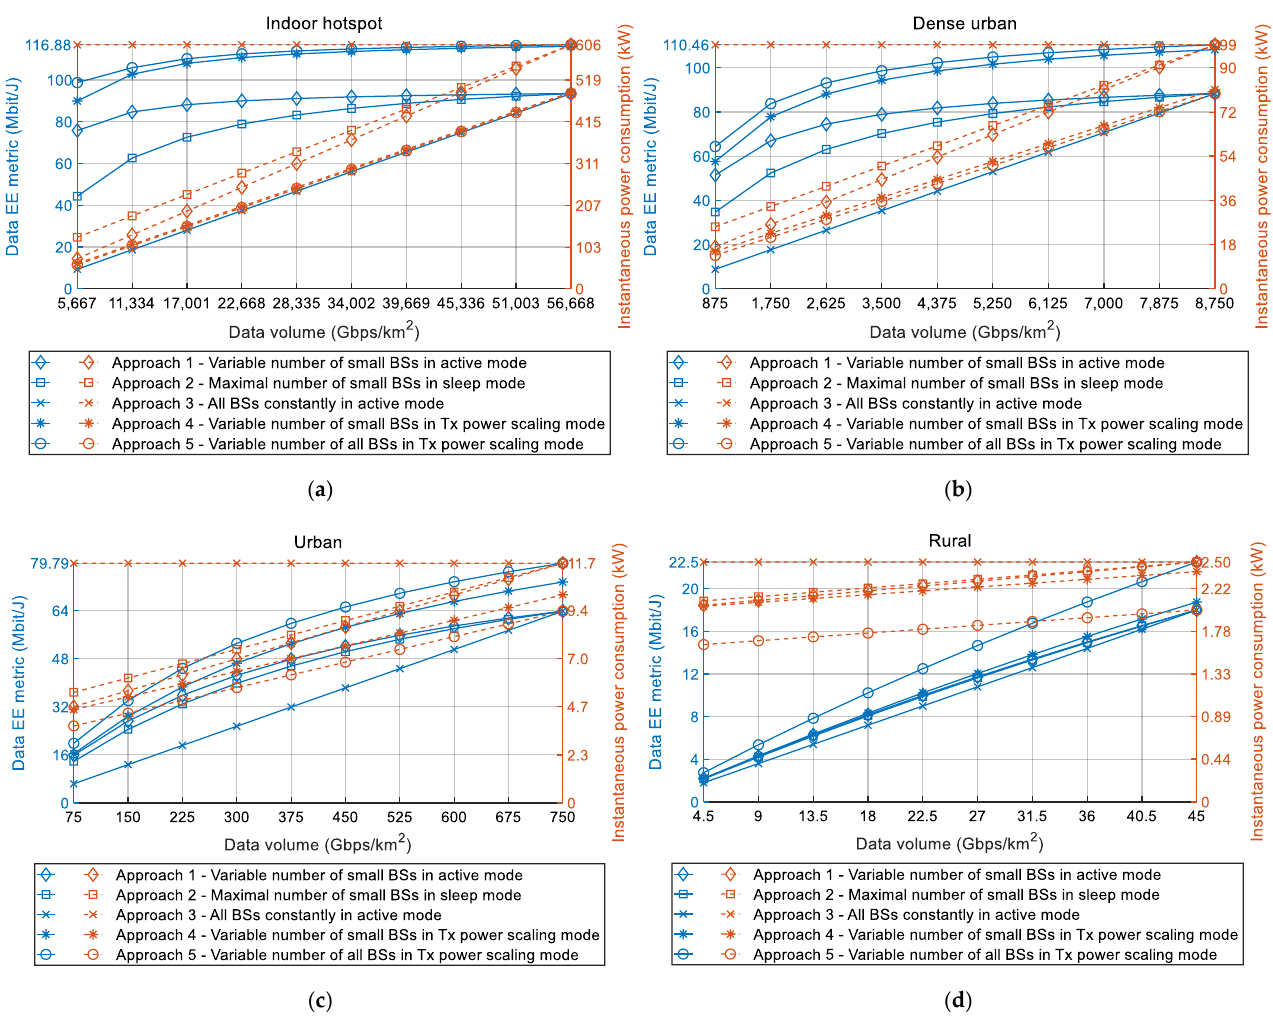
Figure 3. Impact of DV increase on data EE metrics and instant 5G network power consumption during the 2020s for ( a ) indoor-hotspot, ( b ) dense-urban, ( c ) urban and ( d ) rural device density class.